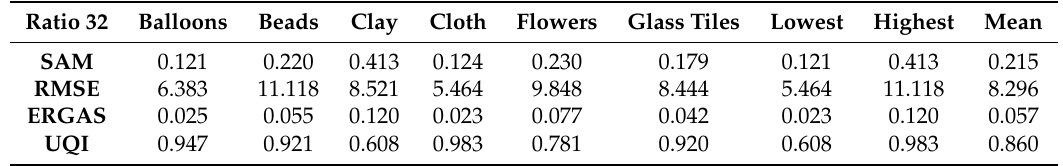
Table 5. Spectral quality indexes for the higher spatial resolution CAVE images trained with input of 16 × 16 pixels.